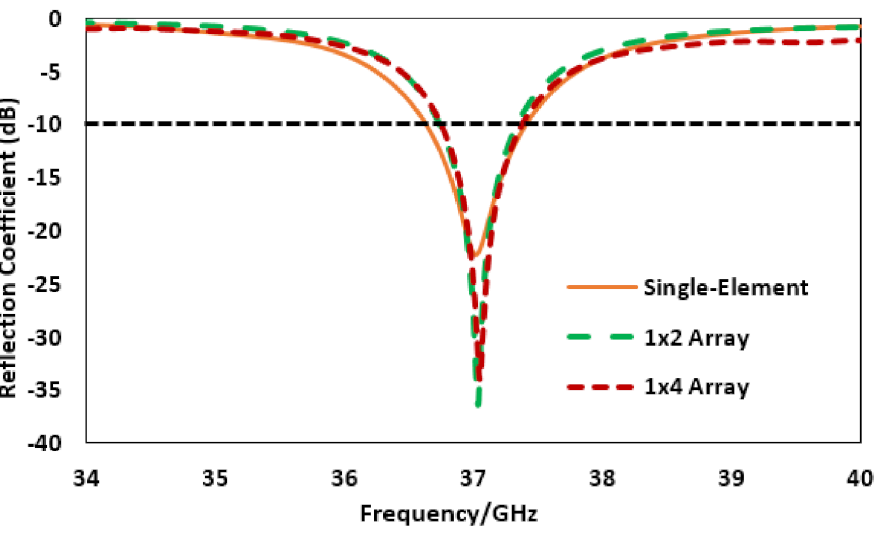
Figure 3. Reflection coefficient comparison for antenna different configurations.